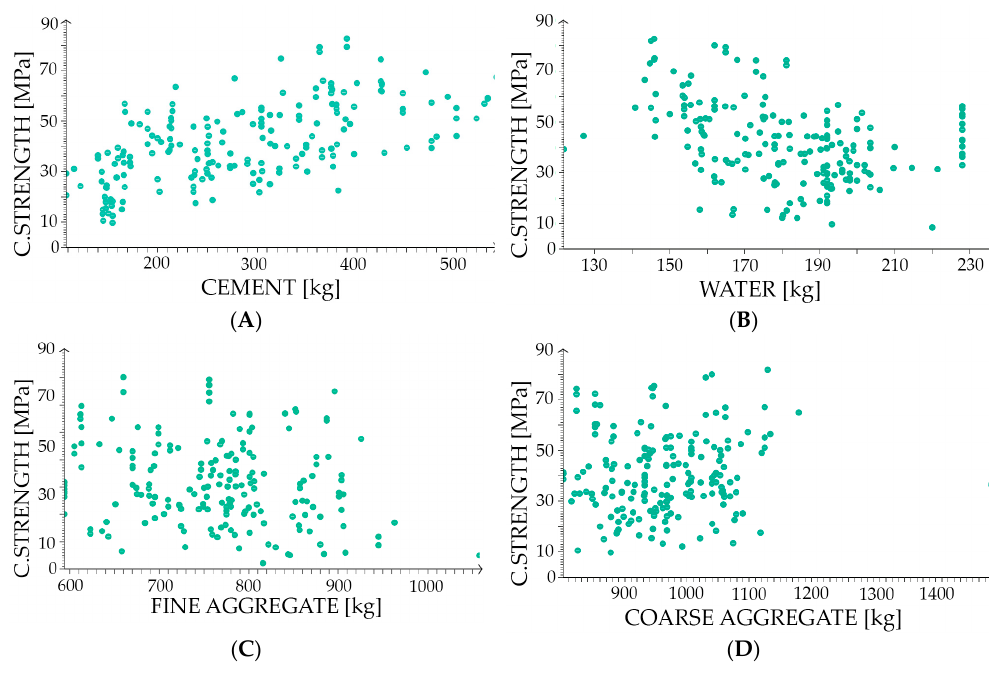
Figure 2. The scatter plots target versus input variables. The vertical axis is the full compressive strength of concrete expressed in megapascals. The horizontal axis is the amount of material in kilograms for cement and aggregate as well as in litres for water. ( A ) Cement; ( B ) water; ( C ) Fine aggregate (sand 0–2 mm); and ( D ) coarse aggregate (aggregate above 2 mm). The legend is in the left bottom corner.